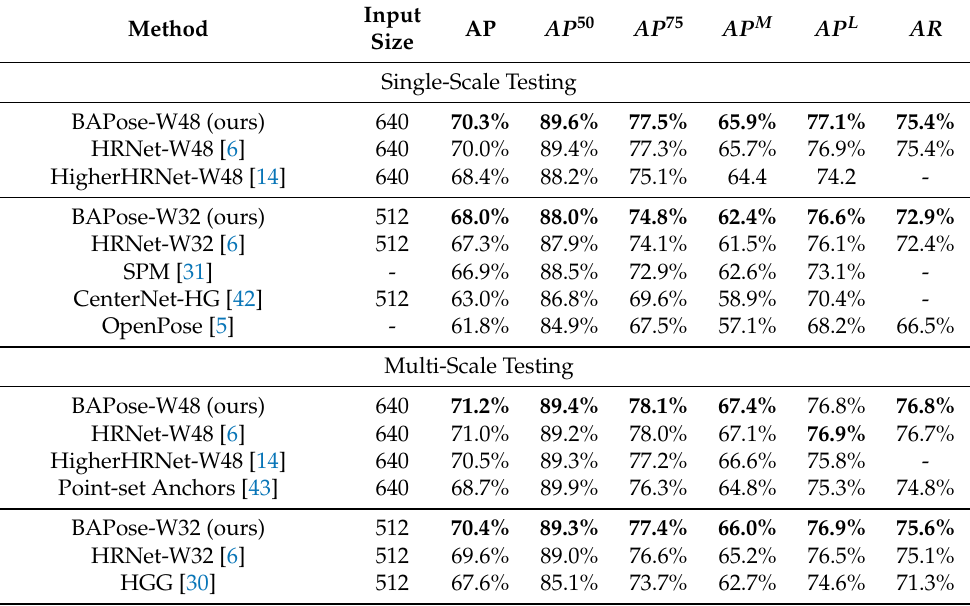
Table 4. BAPose results and comparison with SOTA methods for the COCO dataset for test-dev. Best results are in bold.